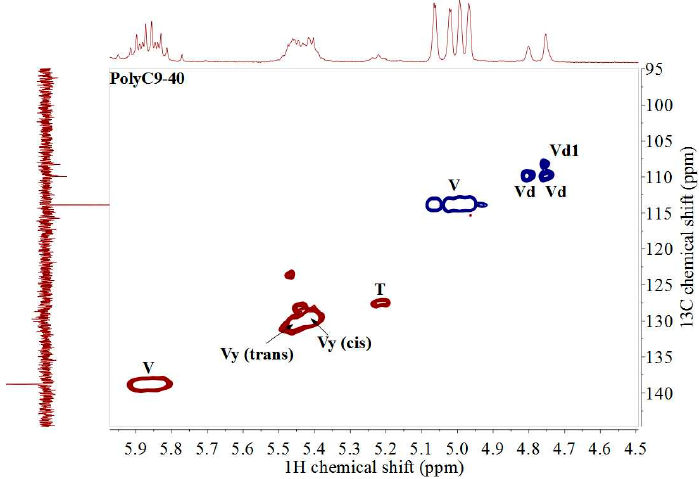
Figure 3. 1 H- 13 C DEPT-HSQC spectrum of the sample polyC 9 40.